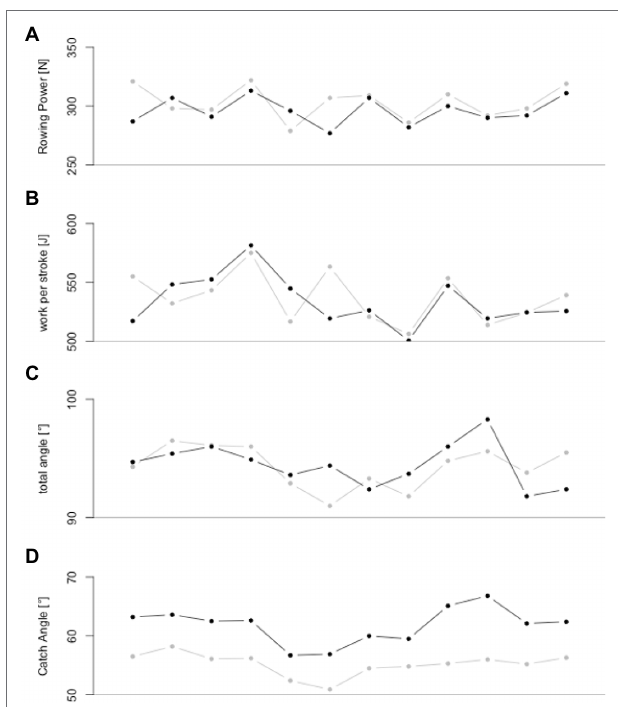
FIGURE 4 | Rowing power (A) , work per stroke (B) , total angle (C) , and catch angle (D) data (means) for both NORM (grey) and GATE (black) during in-field boat measurement of the elite